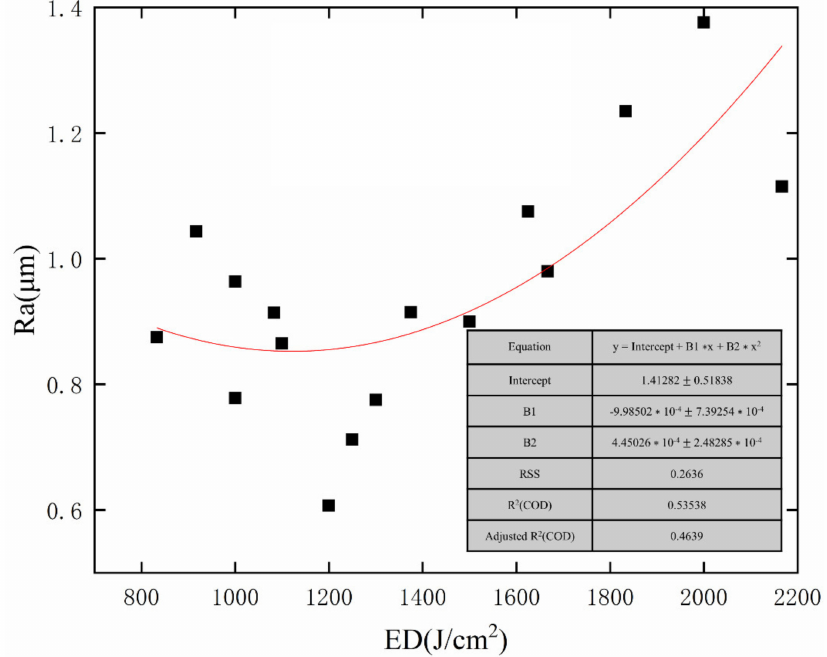
Figure 3. The relationship between energy density (ED) and surface roughness (Ra) assisted by magnetic field.